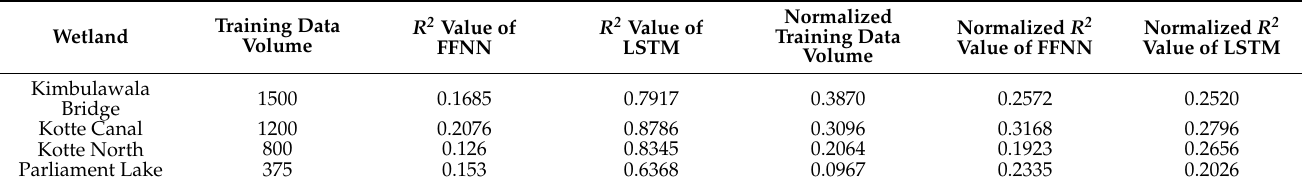
Table 5. Normalized performances and training data volume.